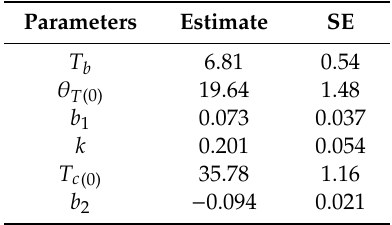
Table 4. Influence of temperature on the germination rates for Conyza canadensis : parameters estimates for Equation (3). T b : base temperature, Θ T (0) : thermal time for seed germination of the quickest seed in the lot, b 1 : slope for Θ T as a function of the percentile, k : shape parameter, T c (0) : ceiling temperature for the quickest seed in the lot, b 2 : slope for T c as a function of the percentile.